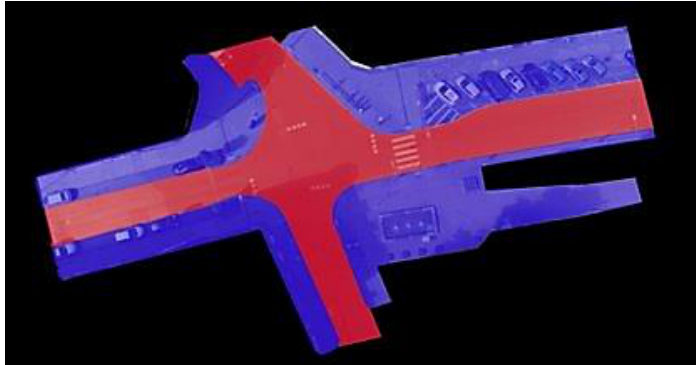
Figure 1. Segmented intersection. Blue represents the sidewalk and red the road.